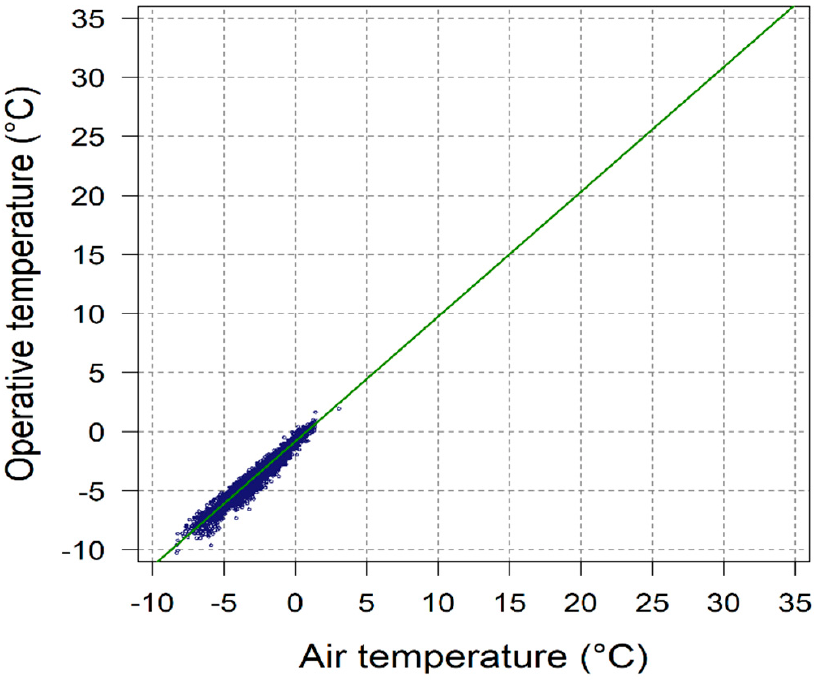
Figure 3. Scatter chart of the operative temperature for the month of January as a function of air temperature for the CarpatClim dataset region in the period 1971–2000.